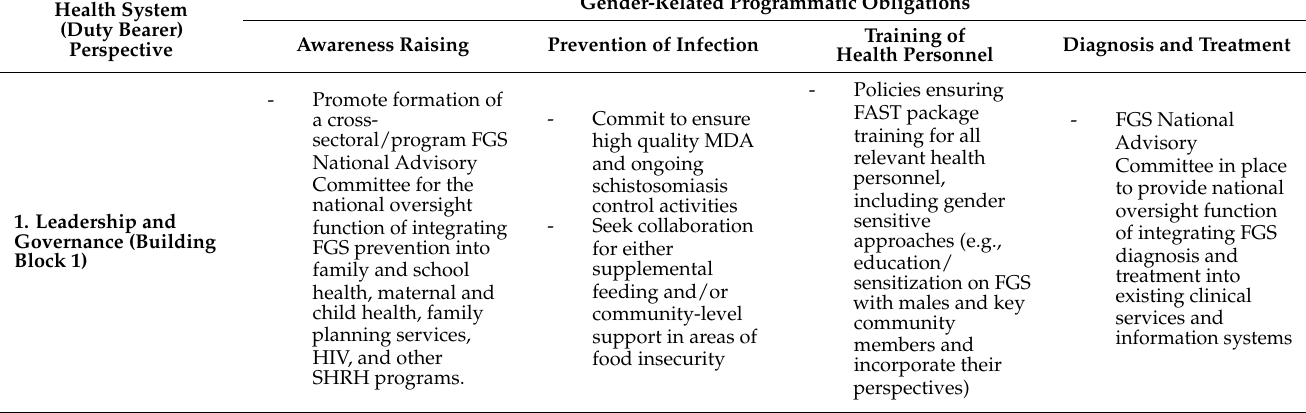
Table 1. Framework (Part 1) to assess gender-related health systems’ obligations vis- à -vis female genital